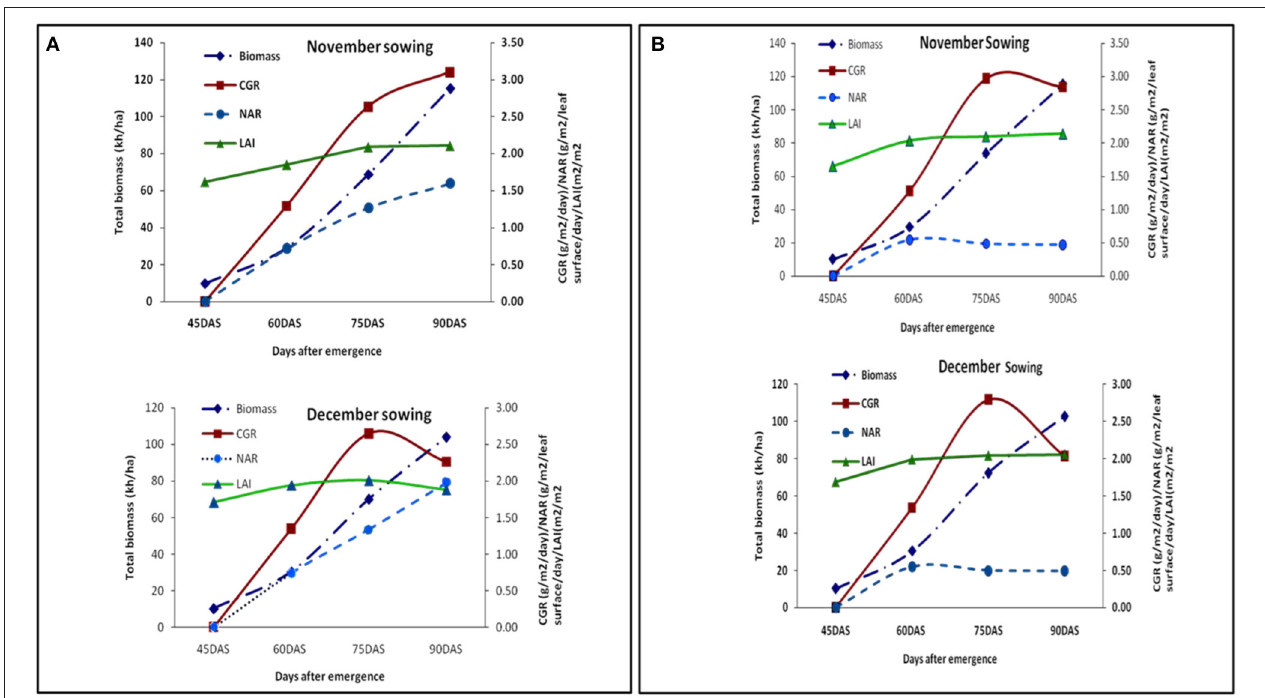
FIGURE 4 | (A) Growth parameters at different growth periods under different dates of sowing (data of 2018–2019 crop seasons); (B) growth parameters at different growth periods under different dates of sowing (data of 2019–2020 crop seasons).